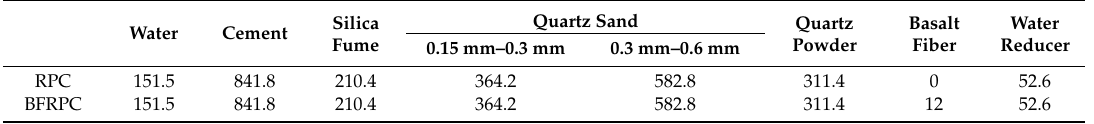
Table 3. Mix proportions of RPC and BFRPC (kg / m 3 ).